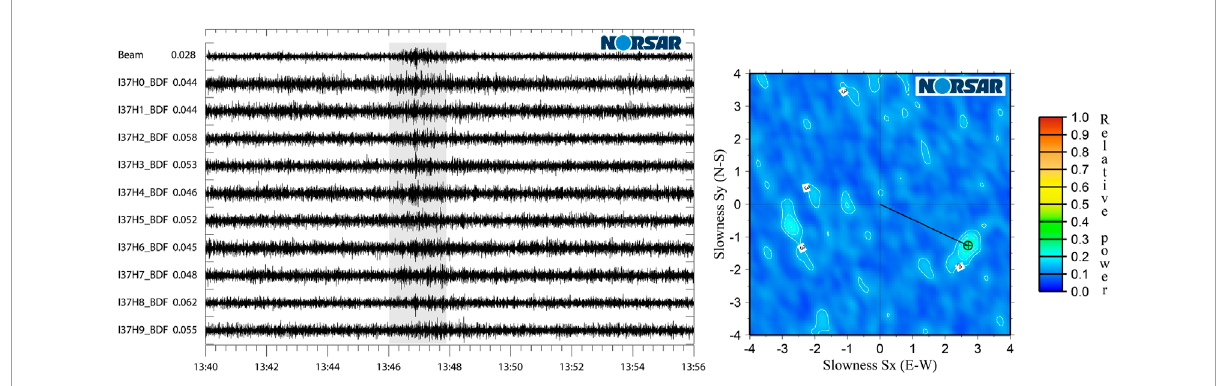
FIGURE 15 Infrasound observations from the Bardufoss IS37 infrasound monitoring station. Top: The sensor signal traces. Bottom: Beamforming results with relative power of the trace stack as function of horizontal slowness, with the maximum relative power indicated.